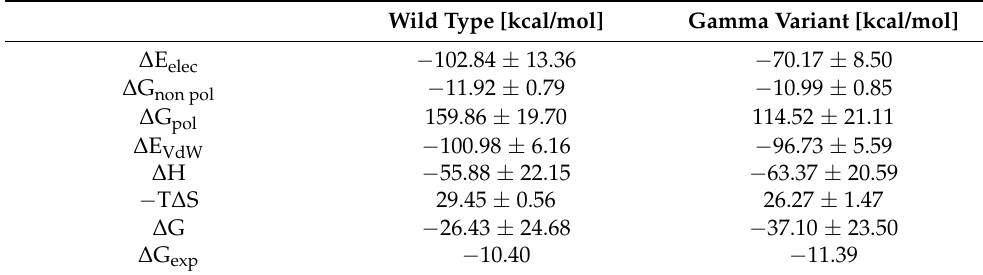
Table 1. MM-PBSA summary results for SARS-CoV-2 Spike RBD/hACE2 wild type complex and gamma variant complex. Values correspond to mean and standard